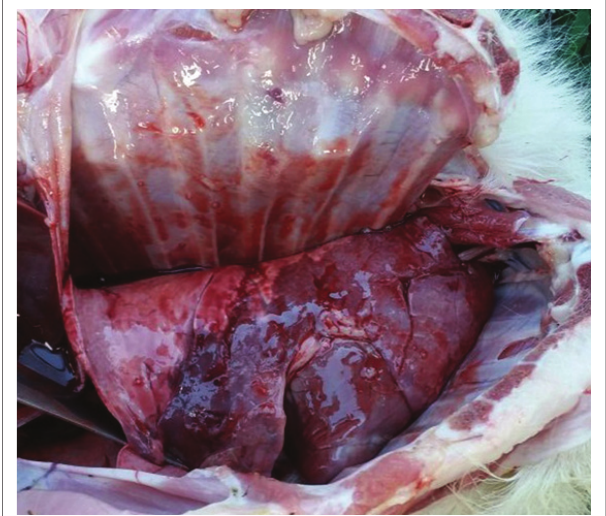
FIGURE 1: Dark red hepatisation or consolidation in the cranioventral lung lobes of the goat kid.